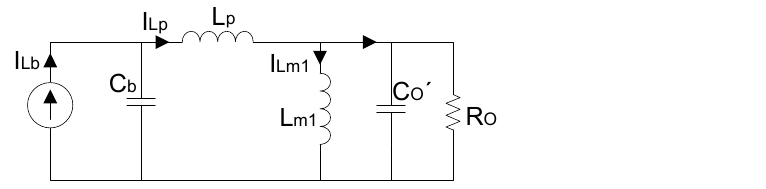
Figure 9. Equivalent circuit of mode IV.